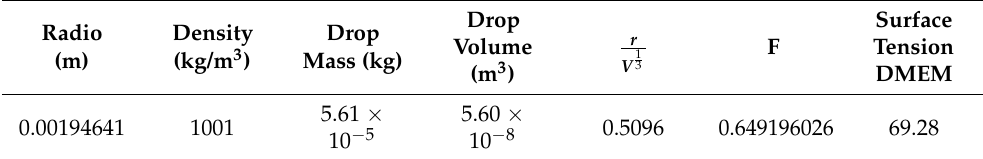
Table 1. Surface tension values of all EnPF meshes.